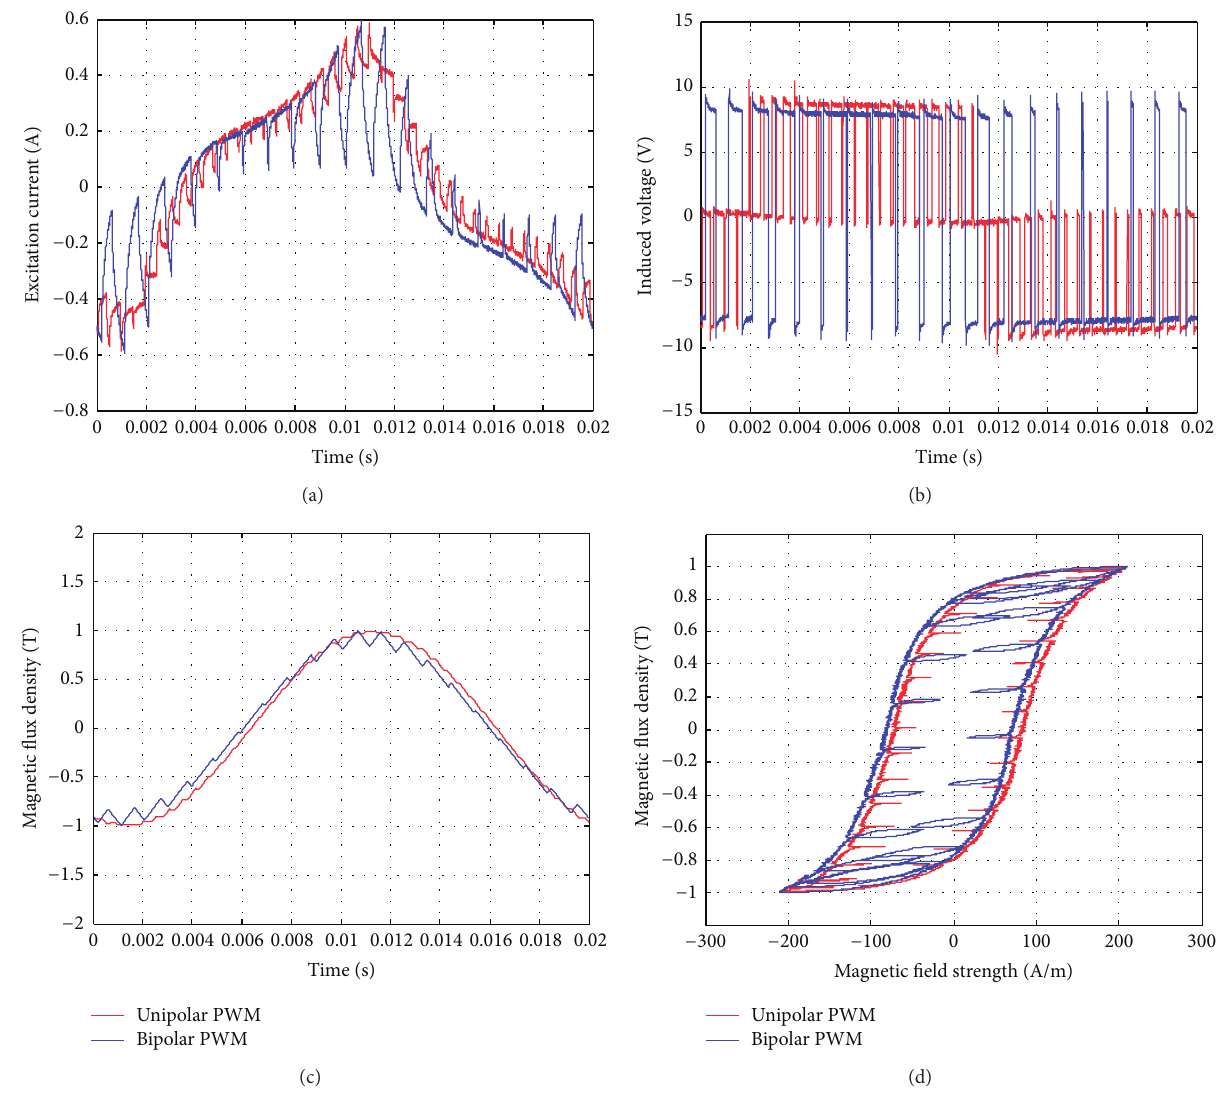
Figure 23: Parameters measured using the new toroidal frame for bipolar and unipolar PWM (with 𝐵 = 1T, 𝑓 = 50 Hz, 𝑚 𝑎 = 0.9 , and = 20 ): (a) excitation current, (b) induced voltage, (c) flux density, and (d) hysteresis curve. 𝑚 𝑓